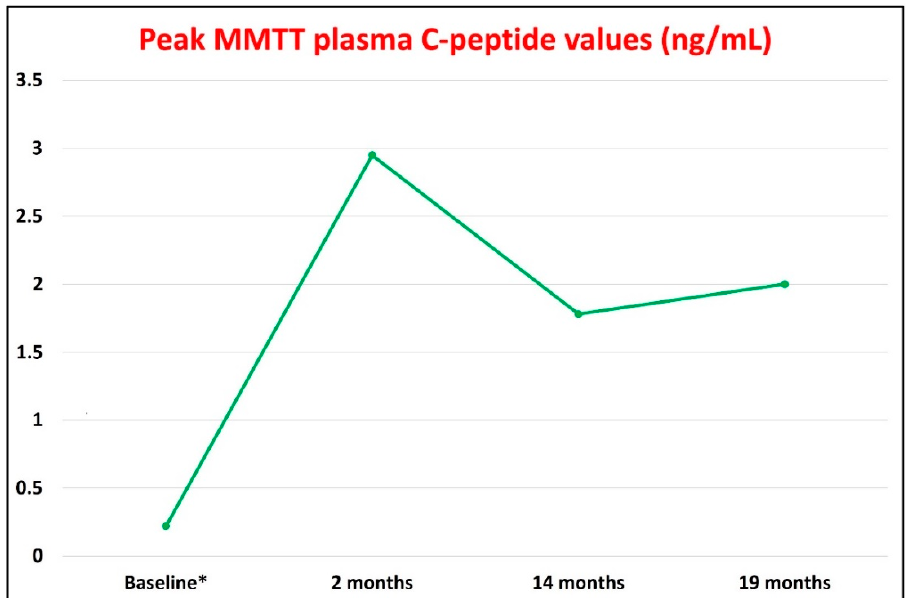
Figure 5. Peak plasma C-peptide values (ng/mL) observed during the 120 min mixed meal tolerance tests (MMTTs) performed at different timepoints of the follow-up period. Baseline timepoint corre- sponds to the occurrence of diabetic ketoacidosis and diagnosis of type 1 diabetes. * Only baseline C-peptide values refer to the fasting state.